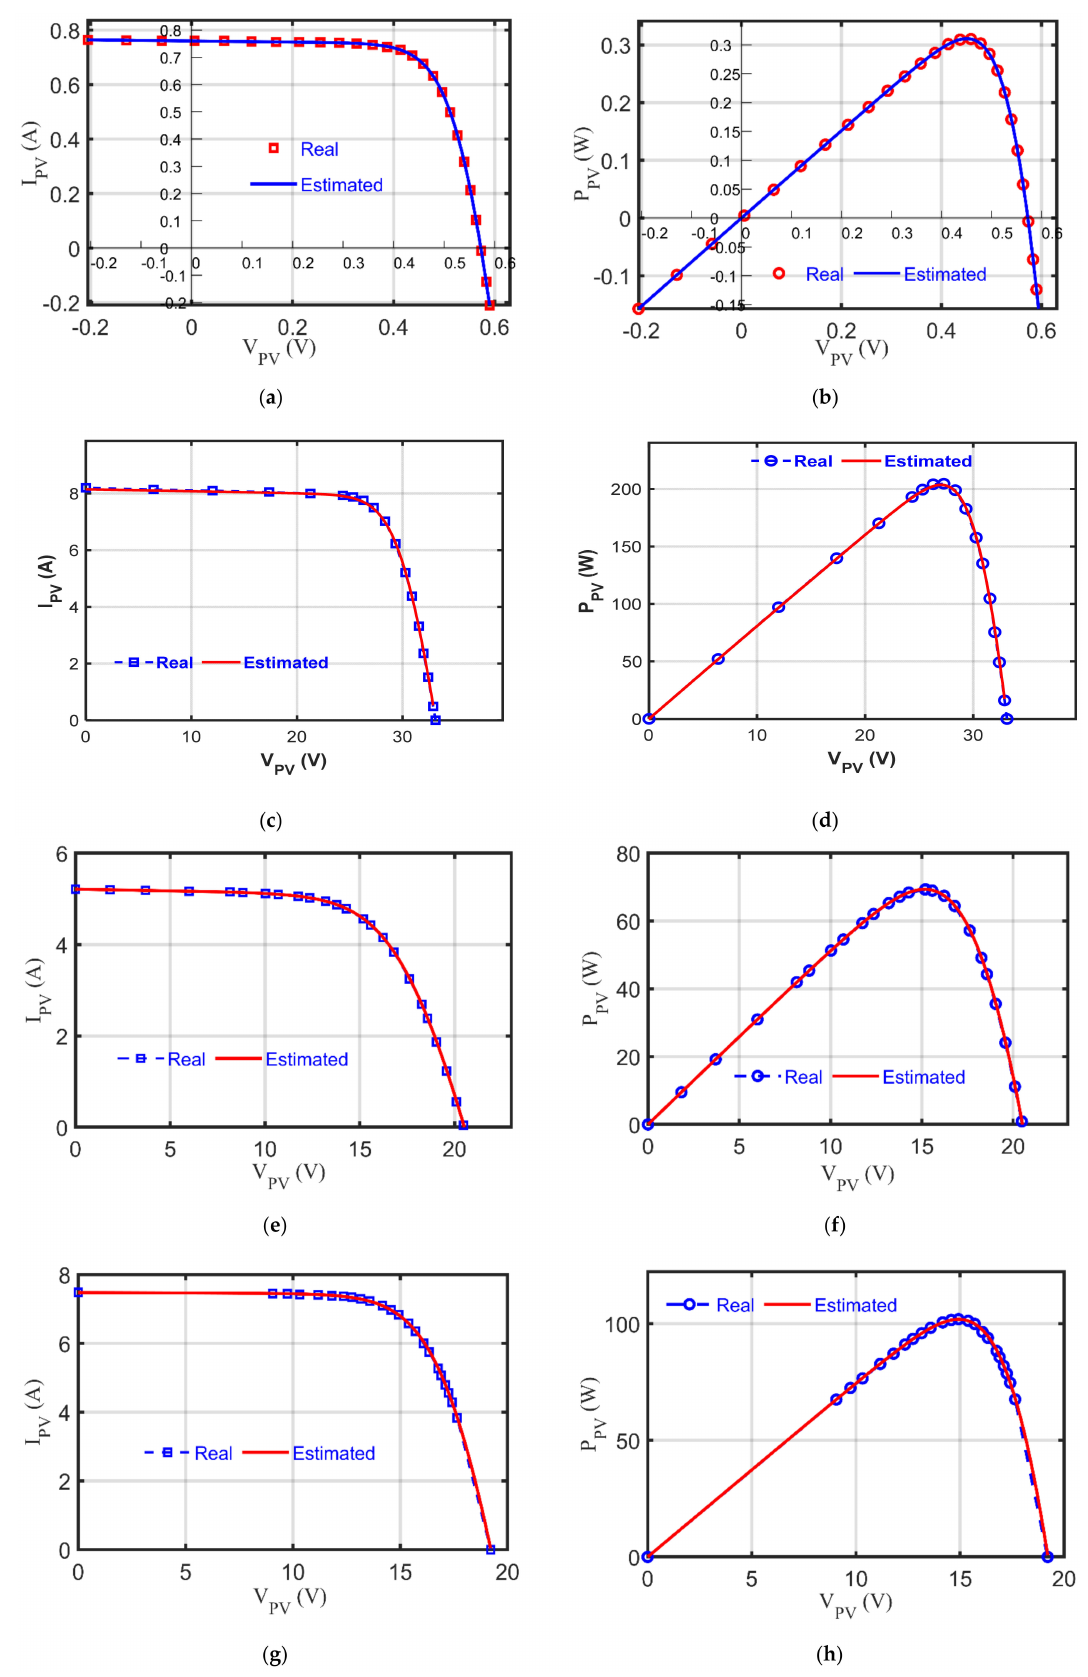
Figure 5. Characteristics curves represented by RGNDO: ( a ) I − V curve of RTC France; ( b ) P − V curve of RTC France; ( c ) I-V curve of Kyocera KC200GT; ( d ) P-V curve of Kyocera KC200GT; ( e ) I − V curve of Ultra 85 − P; ( f ) P − V curve of Ultra 85-P; ( g ) I − V curve of STP6 − 120/36 module; ( h ) P-V curve of STP6 −